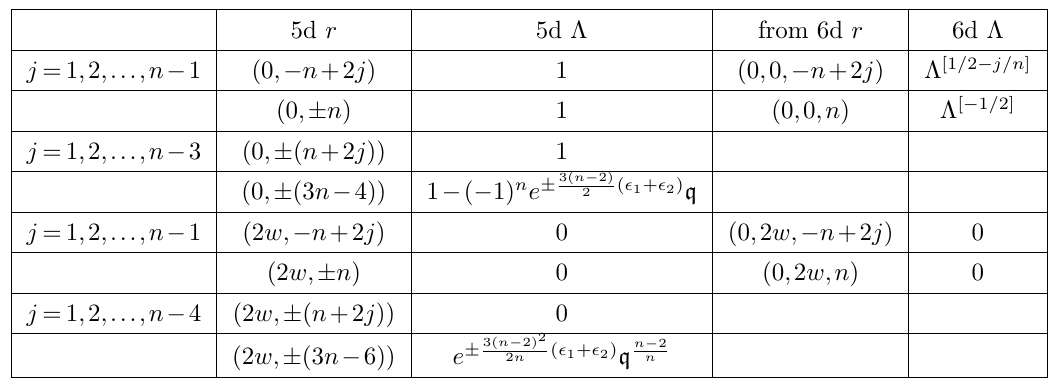
Table 10 . The 5d and 6d blowup equations for pure gauge theories with G = A 2 , D 4 , F 4 , E 6 , 7 , 8 and corresponding n = 3 , 4 , 5 , 6 , 8 , 12 . The 5d r fields are denoted as ( r w ∈ ( P ∨ \ Q ∨ ) G and 6d r fields are denoted as ( r τ , r m